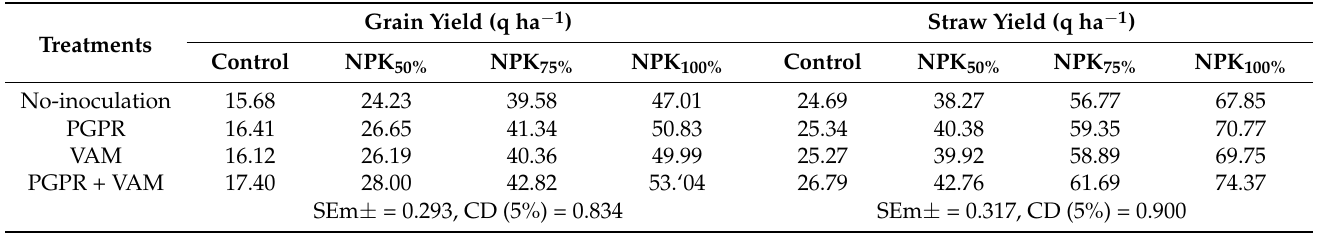
Table 8. Interaction effect of fertility levels, FYM, and bio-inoculants on the economics (B:C ratio) of wheat (mean of two